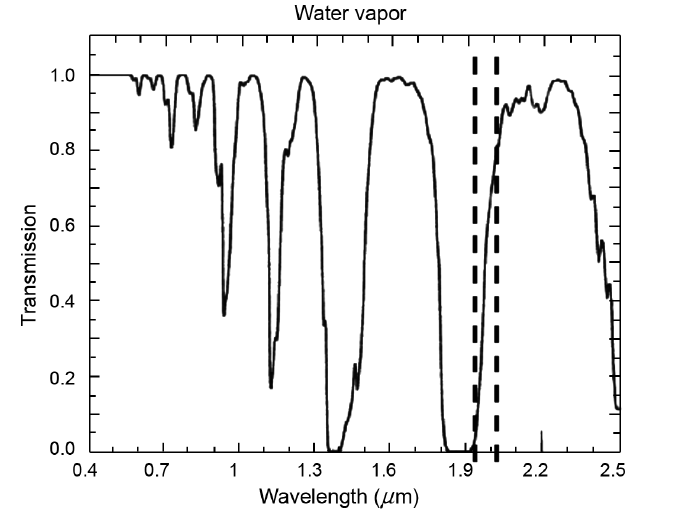
Fig. 9. DAIS bands involved in water vapor absorption range.